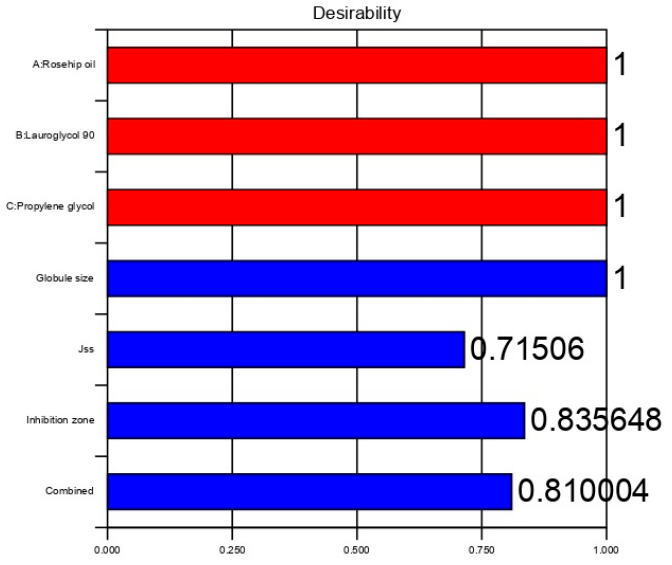
Figure 5. Bar chart showing the desirability of the selected design.